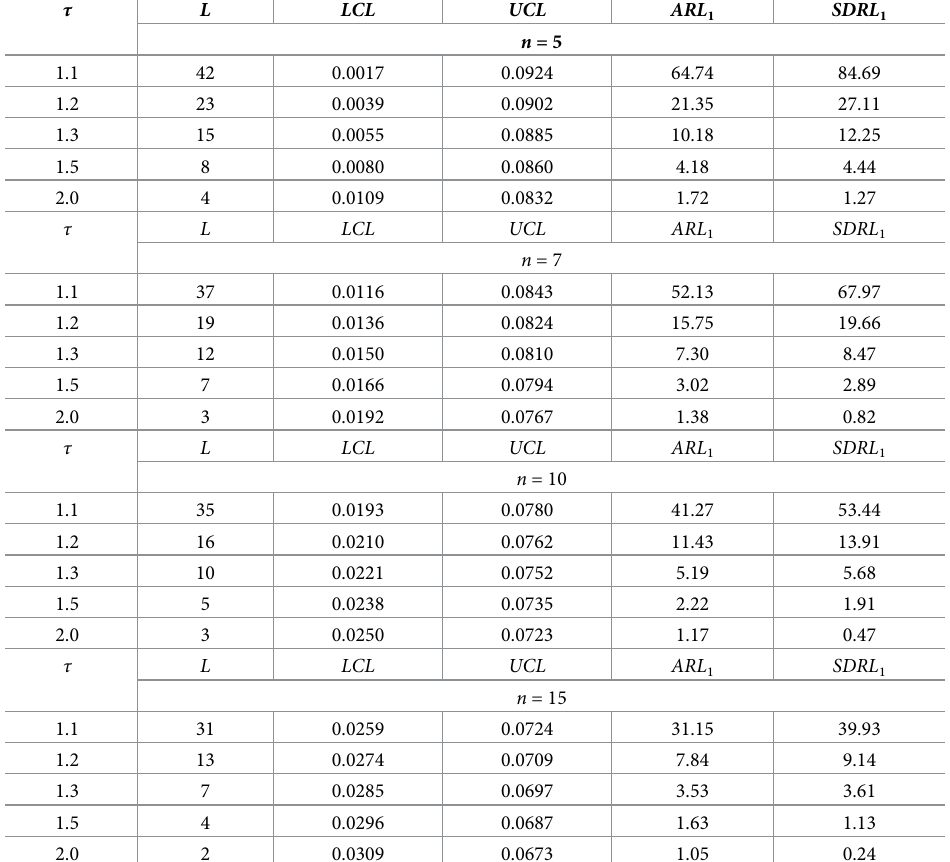
Table 1. Optimal charting parameters and the corresponding ARL 1 and SDRL 1 values for the ARL -based side sen- sitive synthetic- γ chart for γ 0 = 0.05, n 2 {5,7,10,15} and τ 2